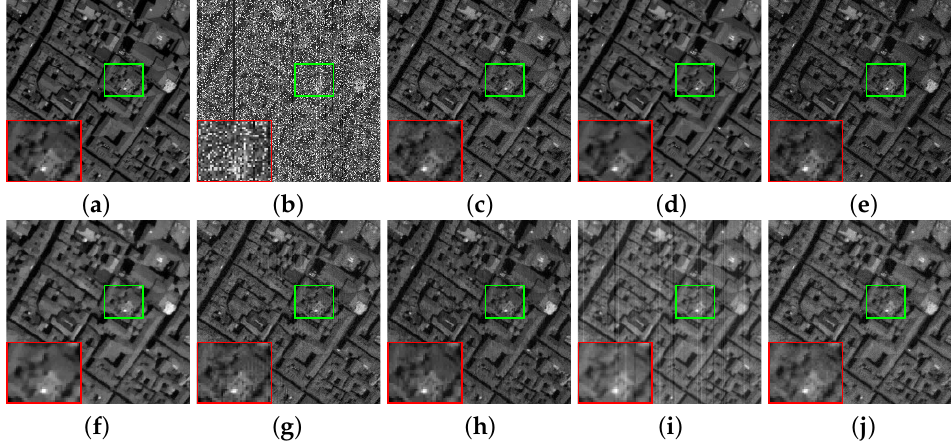
Figure 4. ( a ) Original image, ( b ) noisy image, image denoised by ( c ) LRTA, ( d ) BM4D, ( e ) LRMR, ( f ) LRTDTV, ( g ) L1HyMixDe, ( h ) LRTDGS, ( i ) 3DTNN, ( j ) ours of band 60 in dataset-1, noise case